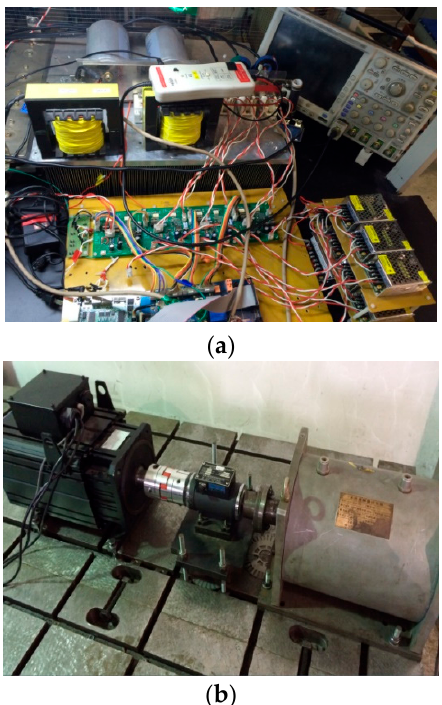
Figure 4. Test bench ( a ) Z-Source inverter; ( b ) PMSM.